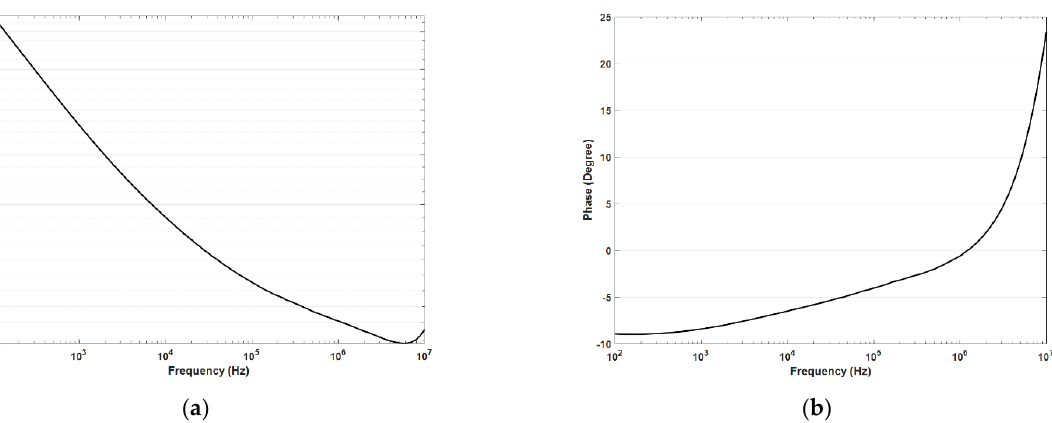
Figure 3. For the sensor including glycerin: ( a ) Impedance amplitude versus frequency relation and ( b ) Phase angle versus frequency